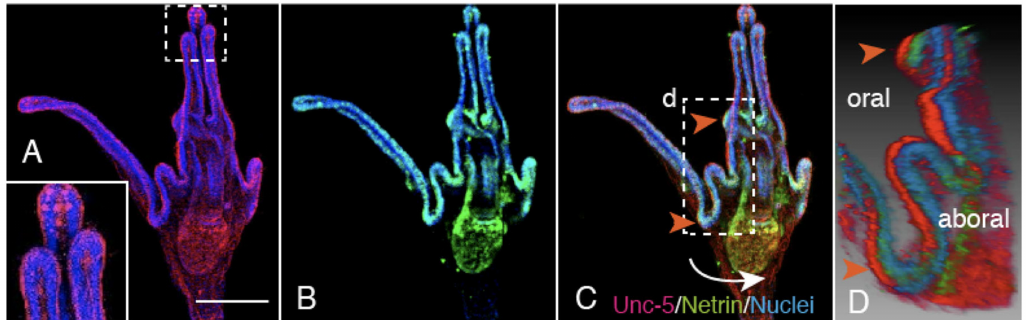
Figure 8. Aboral view of triple-stained 10dpf-6aPL with Unc-5 (red), Netrin (green), and Nuclei (blue). ( A ) Confocal laser scanning microscopy (CLSM) shows the Unc-5-positive CBAS. Inset: higher magnification of the rectangle shows Unc-5-positive cells in the blastocoel of the arm tip. ( B ) CLSM of the same larva shows the Netrin stripe (green). ( C ) Merged image between (A) and (B) shows the CBAS on the Netrin stripe. ( *D ) 3D-reconstructed image of the area, indicated by a rectangle in (C), was rotated to the direction shown by a curved arrow to show the Unc-5-positive CBAS on the oral side of the Netrin stripe (red arrowheads in C and D). Scale bar = 75 µ m. * Refer to Supplemental Figure